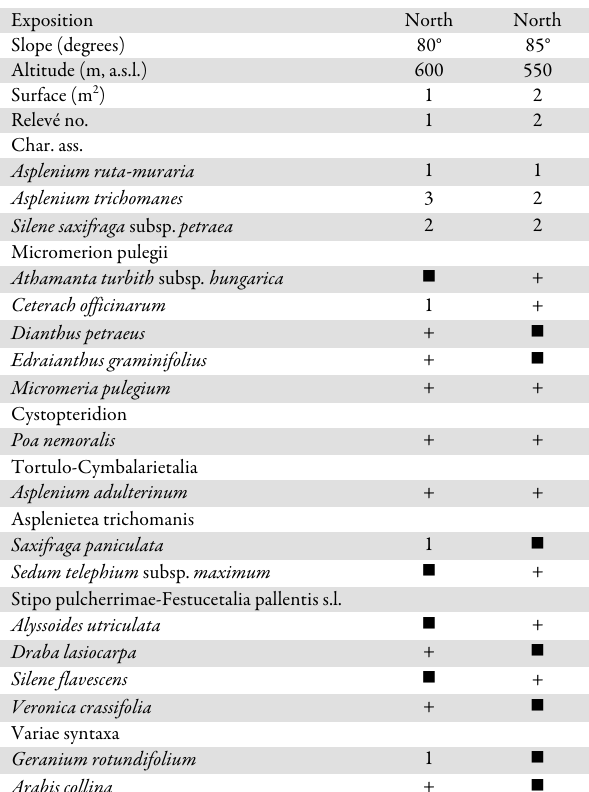
Table 1. Associations of Asplenio-Silenetum petraeae Bo ş caiu